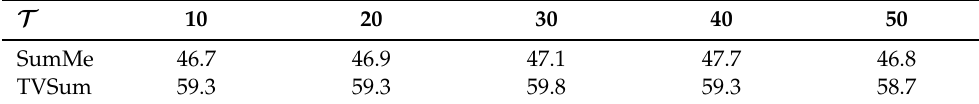
Table 7. Performance with different sampling intervals T on two